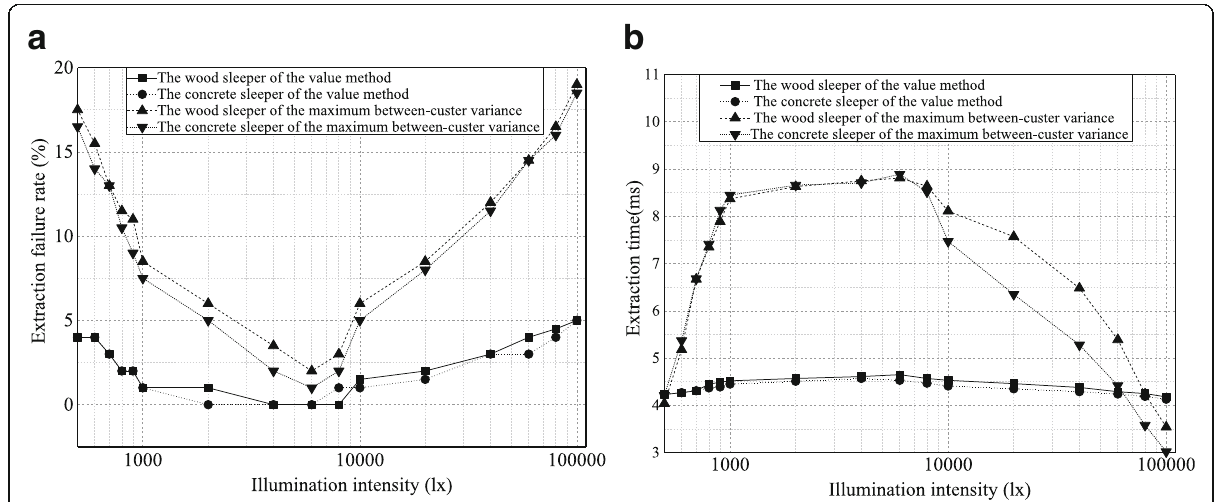
Fig. 14 Test results of different light intensity. a Extraction failure rate. b Extraction